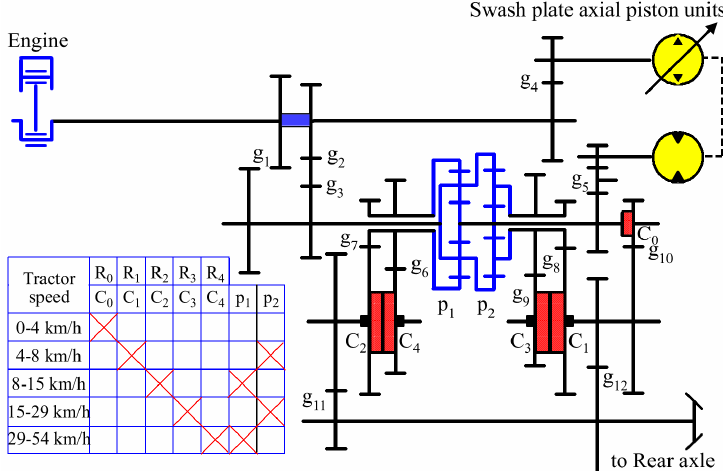
Figure 1. Schematic diagram of the hydrostatic power split CVT.